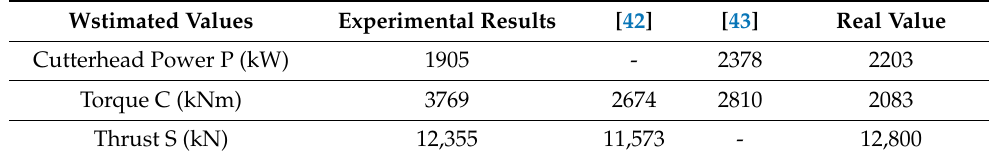
Table 4. P, C, S values estimated with the experimental models and real values. Wstimated Values Experimental